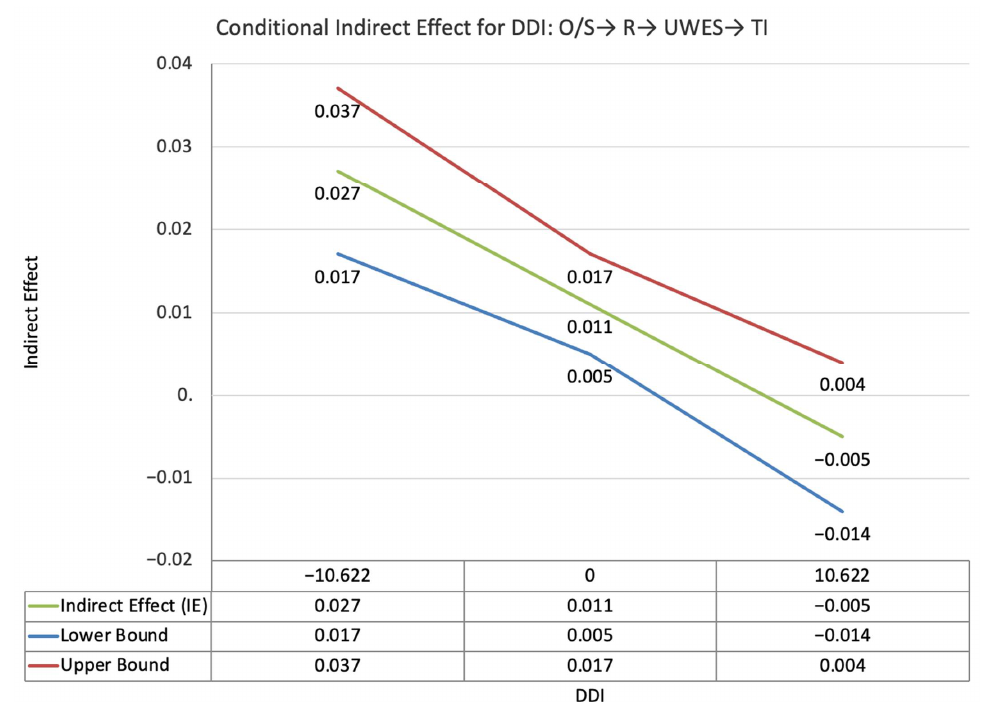
Figure 13. Conditional indirect effects of the difference between self-PMIEs compared to other- PMIEs on at low, average and high levels of self-disclosure, through relatedness satisfaction and work engagement.